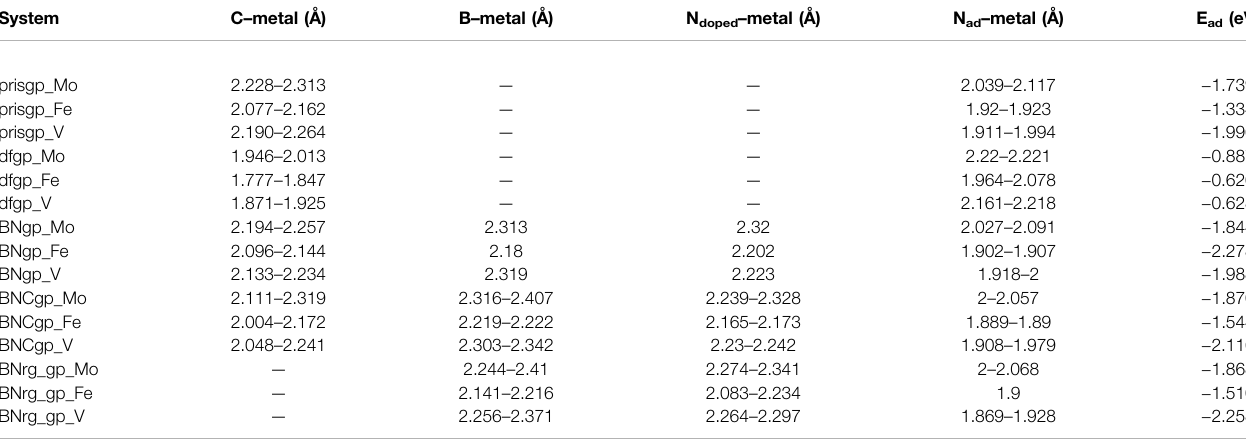
TABLE 2 | Interatomic distances and adsorption energies of N 2 on Mo, V, and Fe on various graphene-based supports (pristine graphene, defective graphene, BN-doped graphene, BNC-ring graphene, BN-ring graphene, and adsorption energy are abbreviated as prisgp, dfgp, BNgp, BNCgp, BNrg_gp, and E ad ).